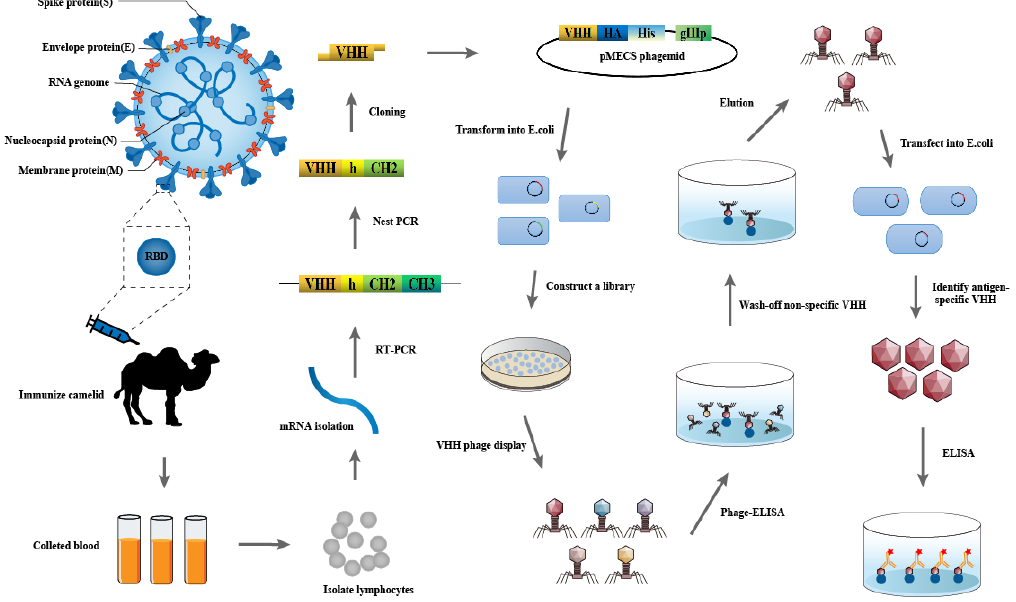
Figure 1. Schematic of the strategy for constructing the immunized library.